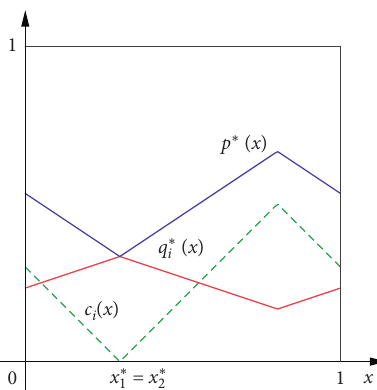
Figure 3: Price and quantity curves with the equilibrium positions at the same point.